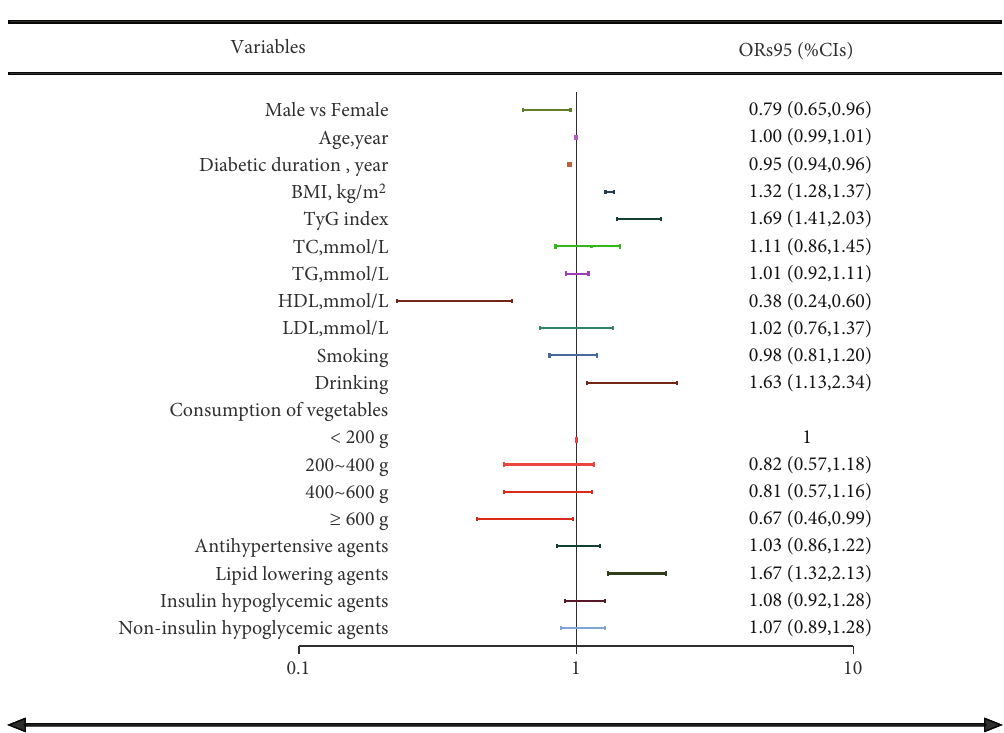
Figure 1: Risk factors for MAFLD in type 2 diabetes. Data are expressed as ORs (95%CIs). MAFLD: metabolic (dysfunction)-associated fatty liver disease; ORs: odds ratios; TyG: triglyceride-glucose index; TC: total cholesterol; TG: triacylglycerols; HDL: high-density lipoprotein cholesterol; LDL: low-density lipoprotein